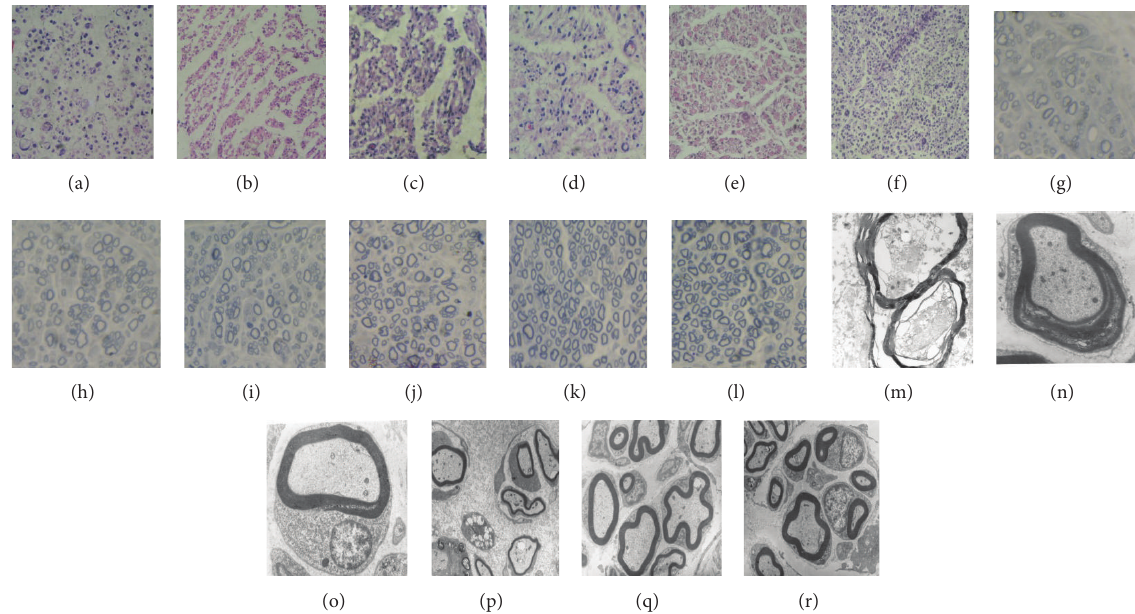
Figure 4: ((a), (b), and (c)) HE staining of transverse nerve slices from each group at 6 w. The regenerated myelinated nerve fibers were sparse; distribution and diameter of the fibers were irregular, but there were no obvious lymphocytic infiltrates. ((d), (e), and (f)) HE staining oftransversenerveslicesfromeachgroupat12 w.(d)ThenumberofregeneratedmyelinatednervefibersingroupAwasincreased;myelinwas relatively dense and irregularly arranged. The number of regenerated myelinated nerve fibers in groups B (e) and C (f) was increased; myelin was dense and regularly arranged; there were blood capillary hyperplasia and no obvious lymphocytic infiltrates. ((g), (h), and (i)) Toluidine blue staining slices from each group at 6 w. (g) The myelin of regenerated myelinated nerve fibers in group A was sparse; the morphology and diameter were irregular. The myelin of regenerated myelinated nerve fibers in groups B (h) and C (i) was dense, but the morphology and diameter were irregular. ((j), (k), and (l)) Toluidine blue staining slices from each group at 12 w. (j) There were large numbers of regenerative and partly myelinated axon in group A and the diameter of them was homogeneous. There were large numbers of regenerative and partly myelinatedaxoningroupsB(k)andC(l)andthediameterofthemwashomogeneousandmyelinsheathwasmorethickerthangroupA.((m), (n), and (o)) Transmission electron microscope from each group at 6 w. (m) The arrangement and thickness of regenerated myelin sheath in group A were irregular. (n) The arrangement of regenerated myelin sheath in group B was more regular than group A, but the thickness of myelin sheath was nonuniform. (o) The arrangement of regenerated myelin sheath in group C was more regular than group A and the thickness of myelin sheath was uniform. ((p), (q), and (r)) Transmission electron microscope from each group at 12w. (p) The regenerated myelin sheath was thin and irregular, accompanied with Schwann cell proliferation. (q) In group B, the regenerated myelin sheath arranges compactly and thicker, accompanied with Schwann cell proliferation. (r) In group C, the regenerated myelin sheath arranges compactly and thicker than groups A and B, accompanied with Schwann cell proliferation and chondriosome, microtubule, and microfilament